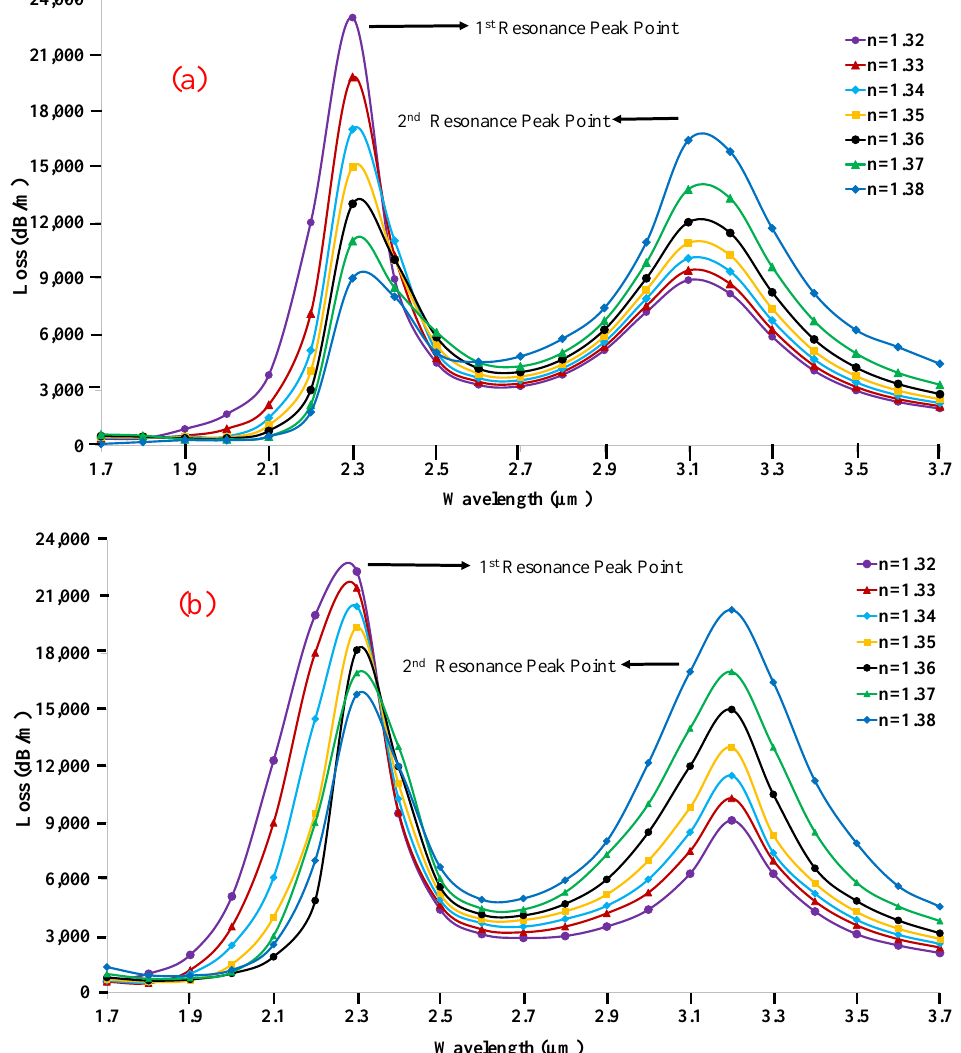
Figure 7. The Confine-loss profile of the proposed C − PCF for ( a ) X- ( b ) Y-polarization versus